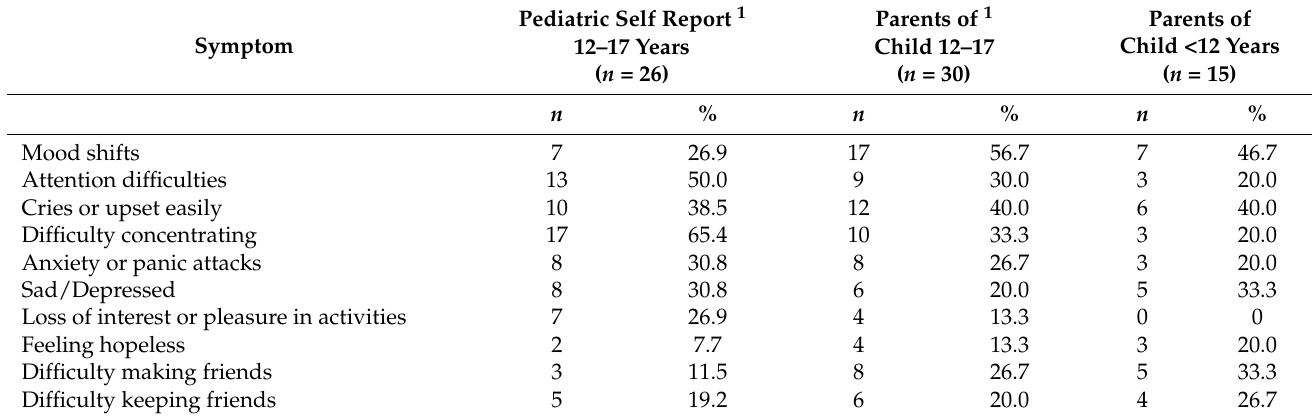
Table 4. Pediatric and parent report of psychosocial symptoms.